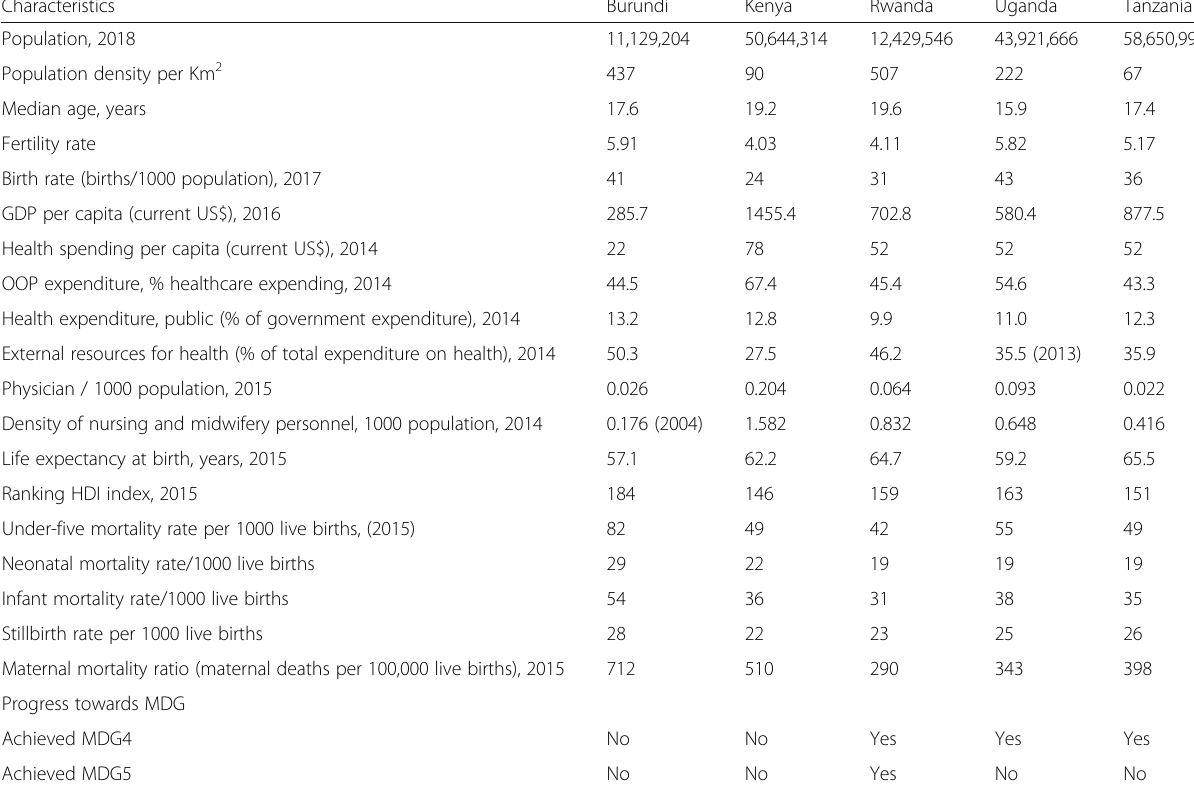
Table 1 Characteristics of the EAC countries included in our analysis